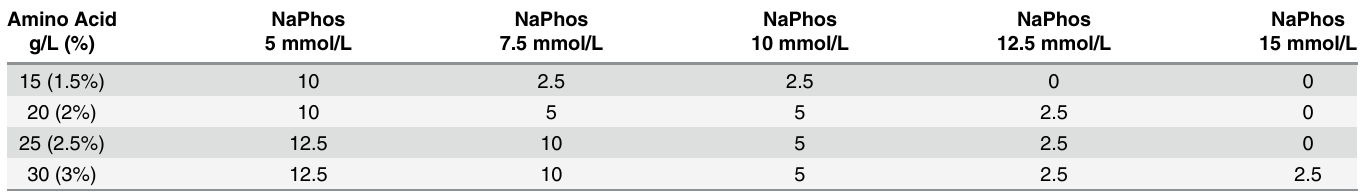
Table 3. Maximum Concentrations (mmol/L) a of Elemental Calcium (as CaCl 2 ) Allowable in TrophAmine Solutions Containing Sodium Phosphate Without Cysteine. Amino Acid